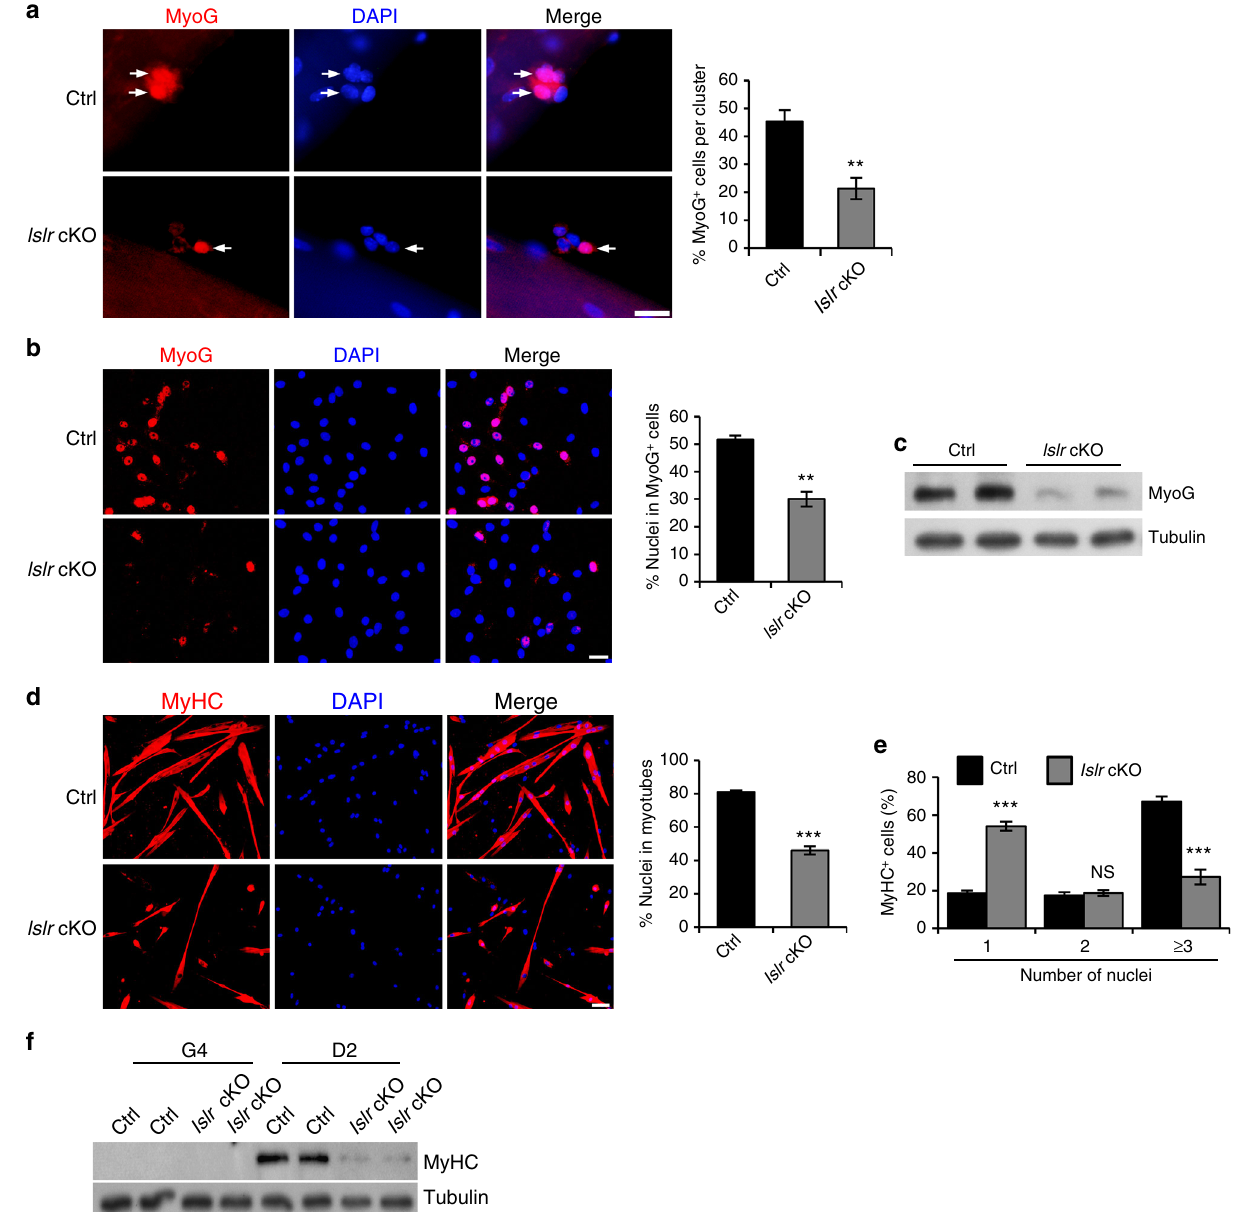
Fig. 4 The differentiation ability of satellite cells is reduced in Islr KO mice in vitro. a Immuno fl uorescence analysis of MyoG + cells in isolated EDL myo fi bers of control and Islr cKO mice after 3 d of culture. N = 3 in each group. Approximately, 30 clusters total in each group. Scale bar = 25 μ m. The percentages of MyoG + cells in the clusters are shown on the right. b Immuno fl uorescence staining for MyoG in FACS-puri fi ed satellite cells from control and Islr cKO mice cultured for 4 d in proliferation medium followed by 1 d in differentiation medium. N = 3 cell cultures in each group. Scale bar = 25 μ m. The percentage of MyoG + cells is shown on the right. c Western blot analysis of MyoG protein levels in isolated satellite cells of control and Islr cKO mice cultured for 4 d in proliferation medium followed by 1 d in differentiation medium. d Immuno fl uorescence staining for MyHC in FACS-puri fi ed satellite cells from control and Islr cKO mice cultured for 4 d in proliferation medium followed by 2 d in differentiation medium. N = 3 cell cultures in each group. Scale bar = 50 μ m. The percentages of nuclei contained in the myotubes (a MyHC + cell with at least two nuclei) are shown on the right. e The distribution of nuclei present in a MyHC + cell differentiated from FACS-puri fi ed satellite cells of control and Islr cKO mice. N = 3 cell cultures in each group. f Western blot analysis of MyHC protein levels in isolated satellite cells of control and Islr cKO mice at 4 d in proliferation medium or 2 d in differentiation medium. Error bars represent the means ± s.d. NS: not signi fi cant, ** P < 0.01, *** P < 0.001; Student ’ s t displayed tightly packed, well-formed muscle fi bers, whereas CreER : Islr fl / fl mice compared to the Islr fl / fl mice (Fig. 5e). In Pax7-CreER : Islr fl / fl mice had many very small muscle fi bers with addition, the numbers of myo fi bers containing two or more centrally located nuclei were also signi fi cantly reduced in Pax7- single nuclei (Fig. 5d, h and Supplementary Fig. 2e). Overall, the CreER : Islr fl / fl mice (Fig. 5f). Meanwhile, the size of eMyHC + phenotype of Pax7-CreER : Islr fl / fl mice was more severe, which fi bers was very small in the regenerating TA muscles of Pax7- demonstrated that Islr had a substantial effect on skeletal muscle CreER : Islr fl / fl mice (Fig. 5g). At 14 d postinjury, Islr fl / fl mice regeneration.